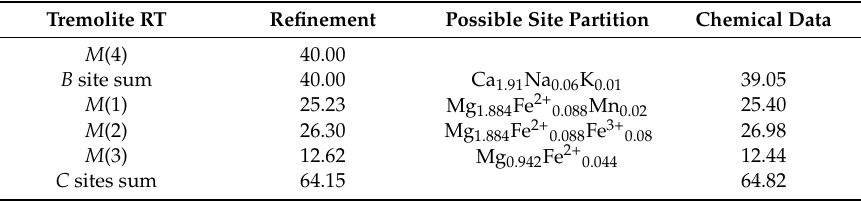
Table 2. Population scheme of the raw tremolite sample as it results from the combination chemical, including Mössbauer [30] and refinement data.